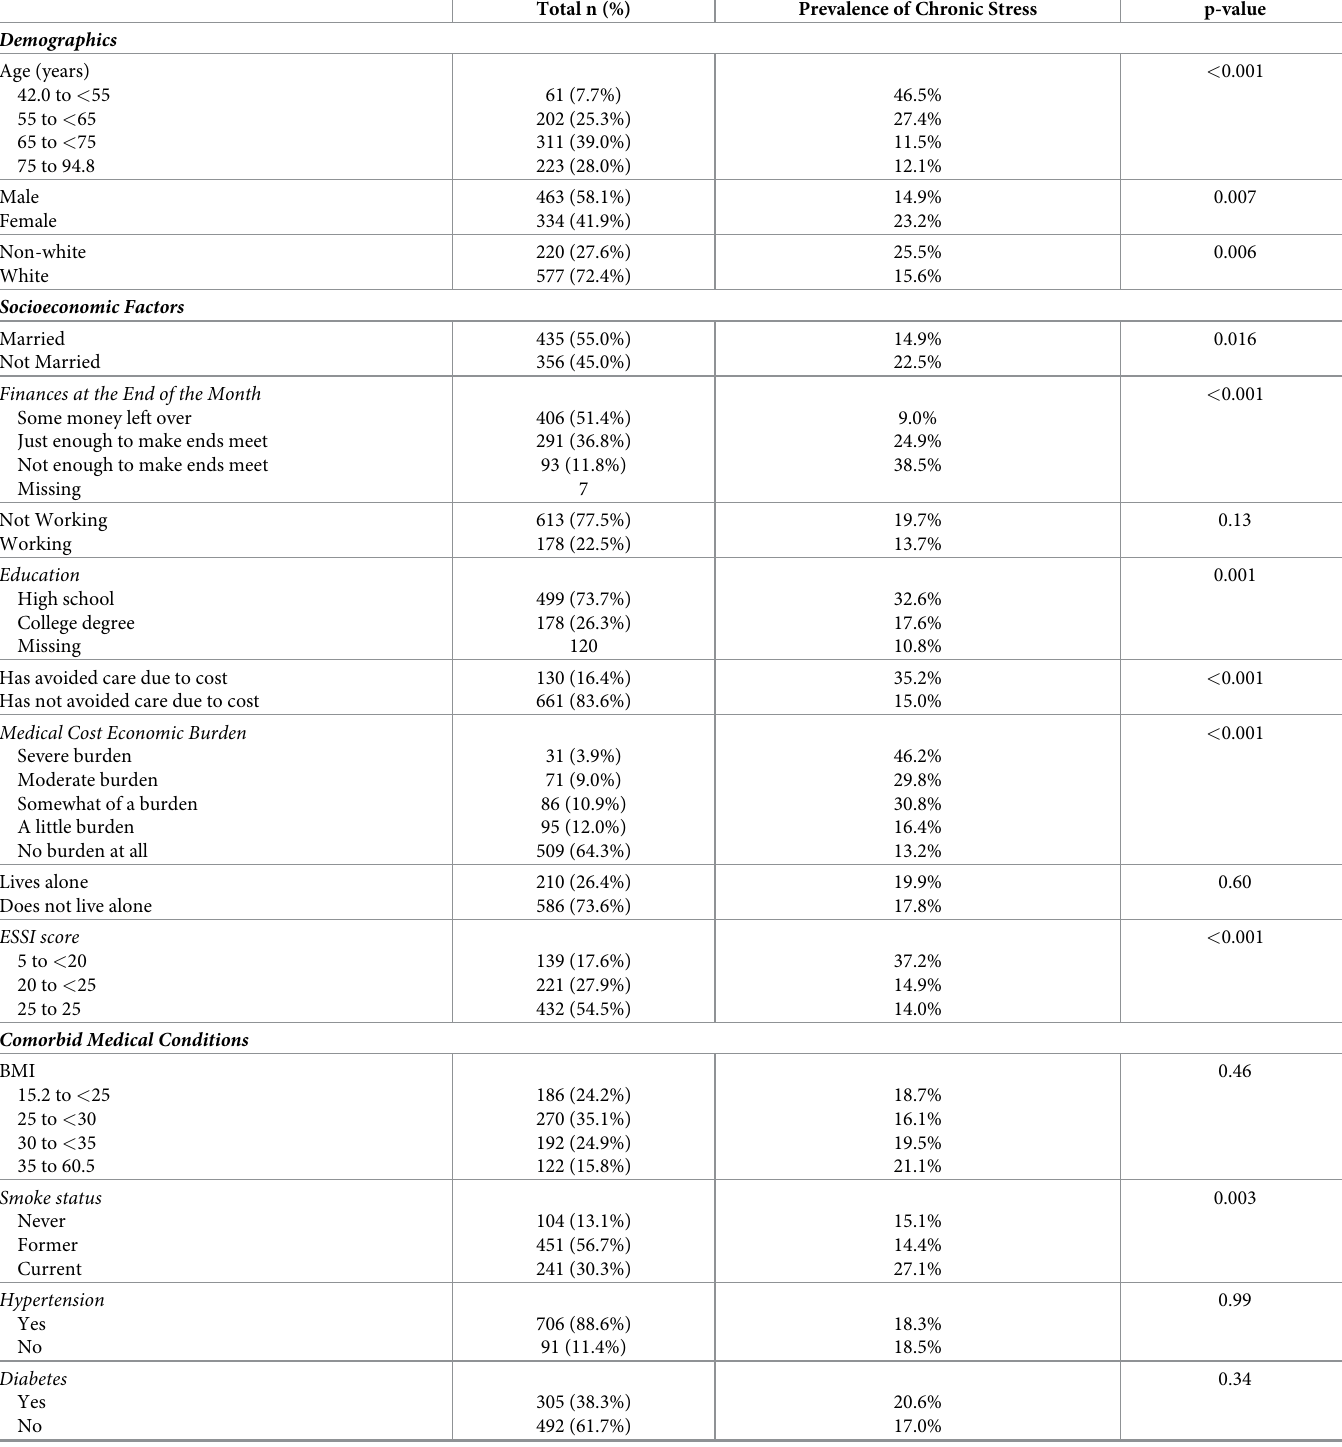
Table 2. Baseline patient characteristics and prevalence of chronic stress in patients from the PORTRAIT